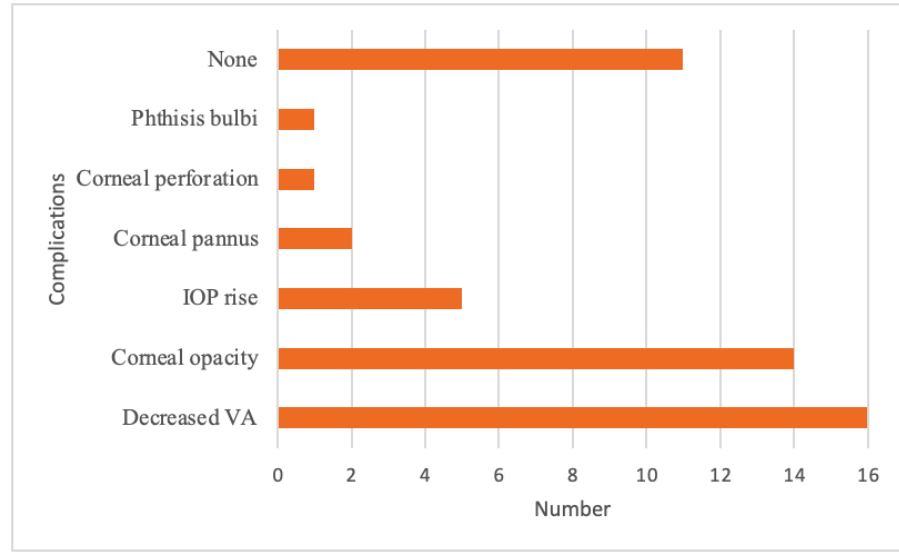
Figure 1. Final complications of adverse drug reactions of tetracaine of the patients who were referred to the eye emergency department for adverse drug reactions of tetracaine in southeast of Iran ( n = 31 eyes). IOP, intraocular pressure; VA, visual